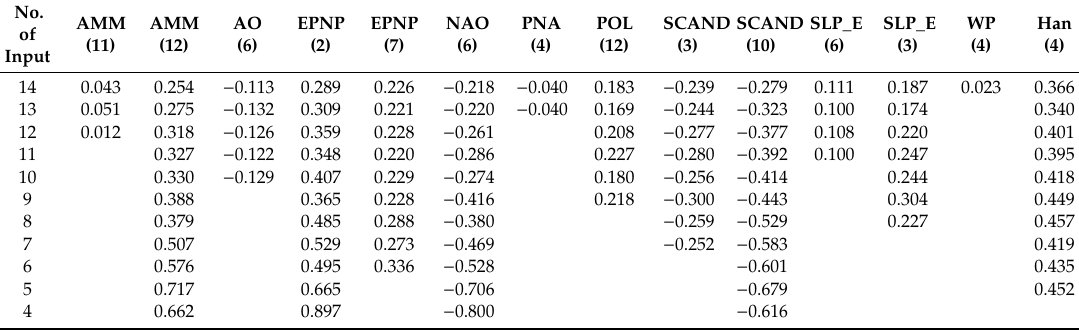
Table 4. Summary of the RI values of the input variables for the ANN-J models.